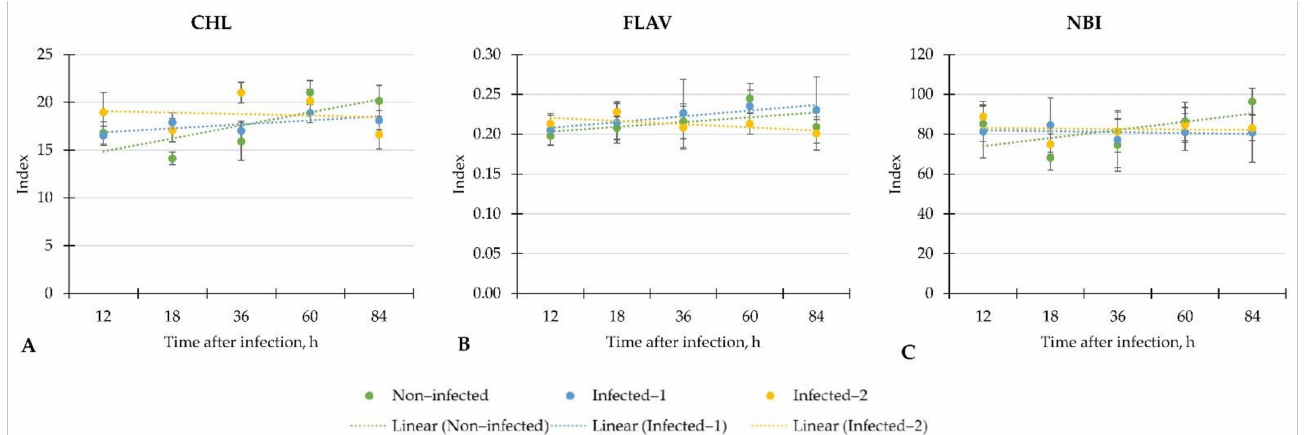
Figure 1. Non-destructive measurements of relative chlorophyll ( A ; CHL), flavonols ( B ; FLAV) contents, and nitrogen balance index ( C ; NBI) of non-infected, artificial infected with B. cinerea disc (Infected-1) and infected with pathogen spore suspension (Infected-2) of “Little Gem” lettuce after 12, 18, 36, 60, and 84 h of artificial